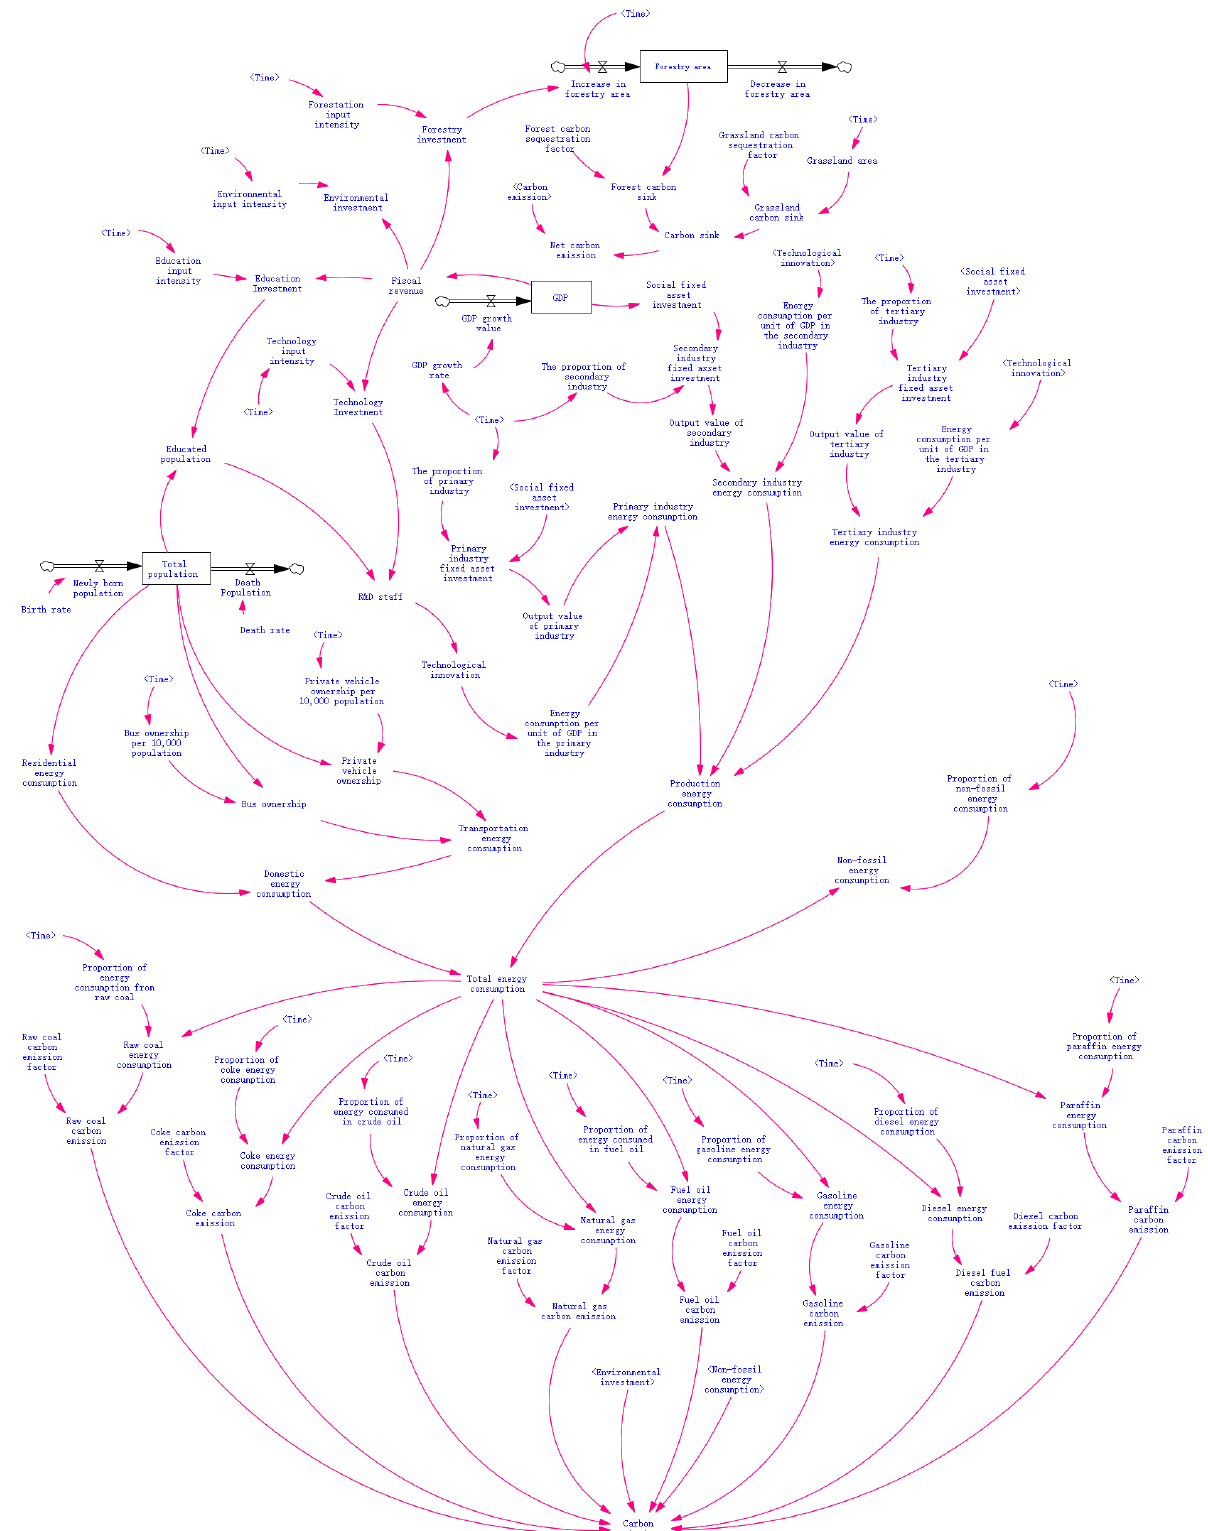
Figure 4. Carbon dioxide emission system flow diagram.